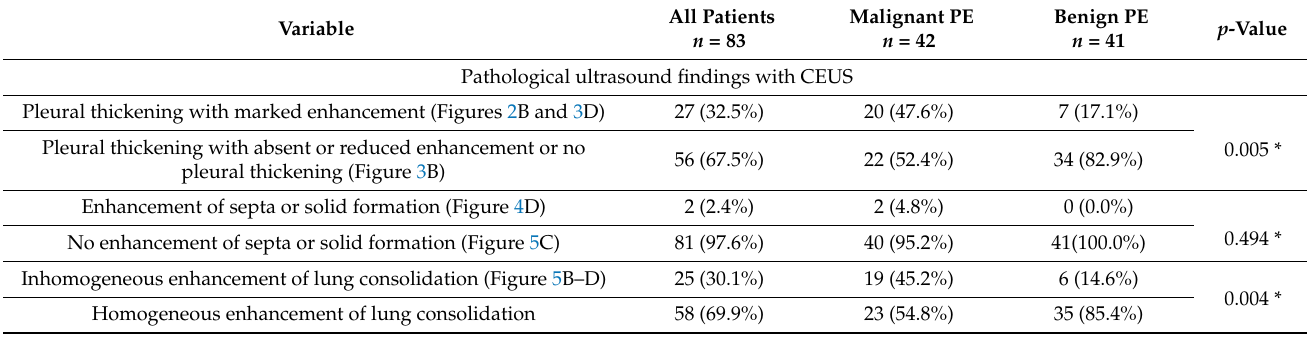
Table 3. CEUS data of the n = 83 patients, subdivided between final malignant and benign PE. Variable